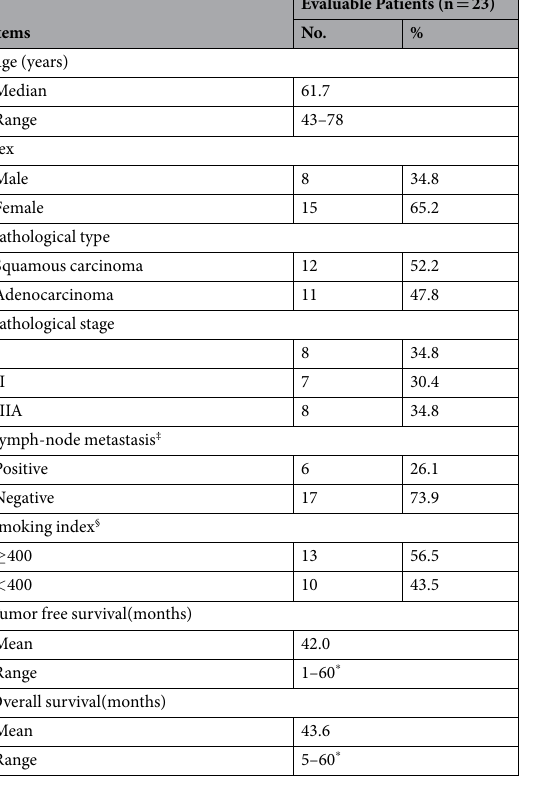
Table 1. Surgically Resected Non-Small Cell Lung Cancer Patients Characteristics. ‡ Cancer patients were pathologically confirmed and divided into lymph node metastasis positive (N1–N3), or negative (N0), respectively. § Smoking index = daily cigarette number × year of smoking; Smoking index ≥ 400 is a high-risk factor of lung cancer. * The last follow-up of tumor free survival or overall survival was 60